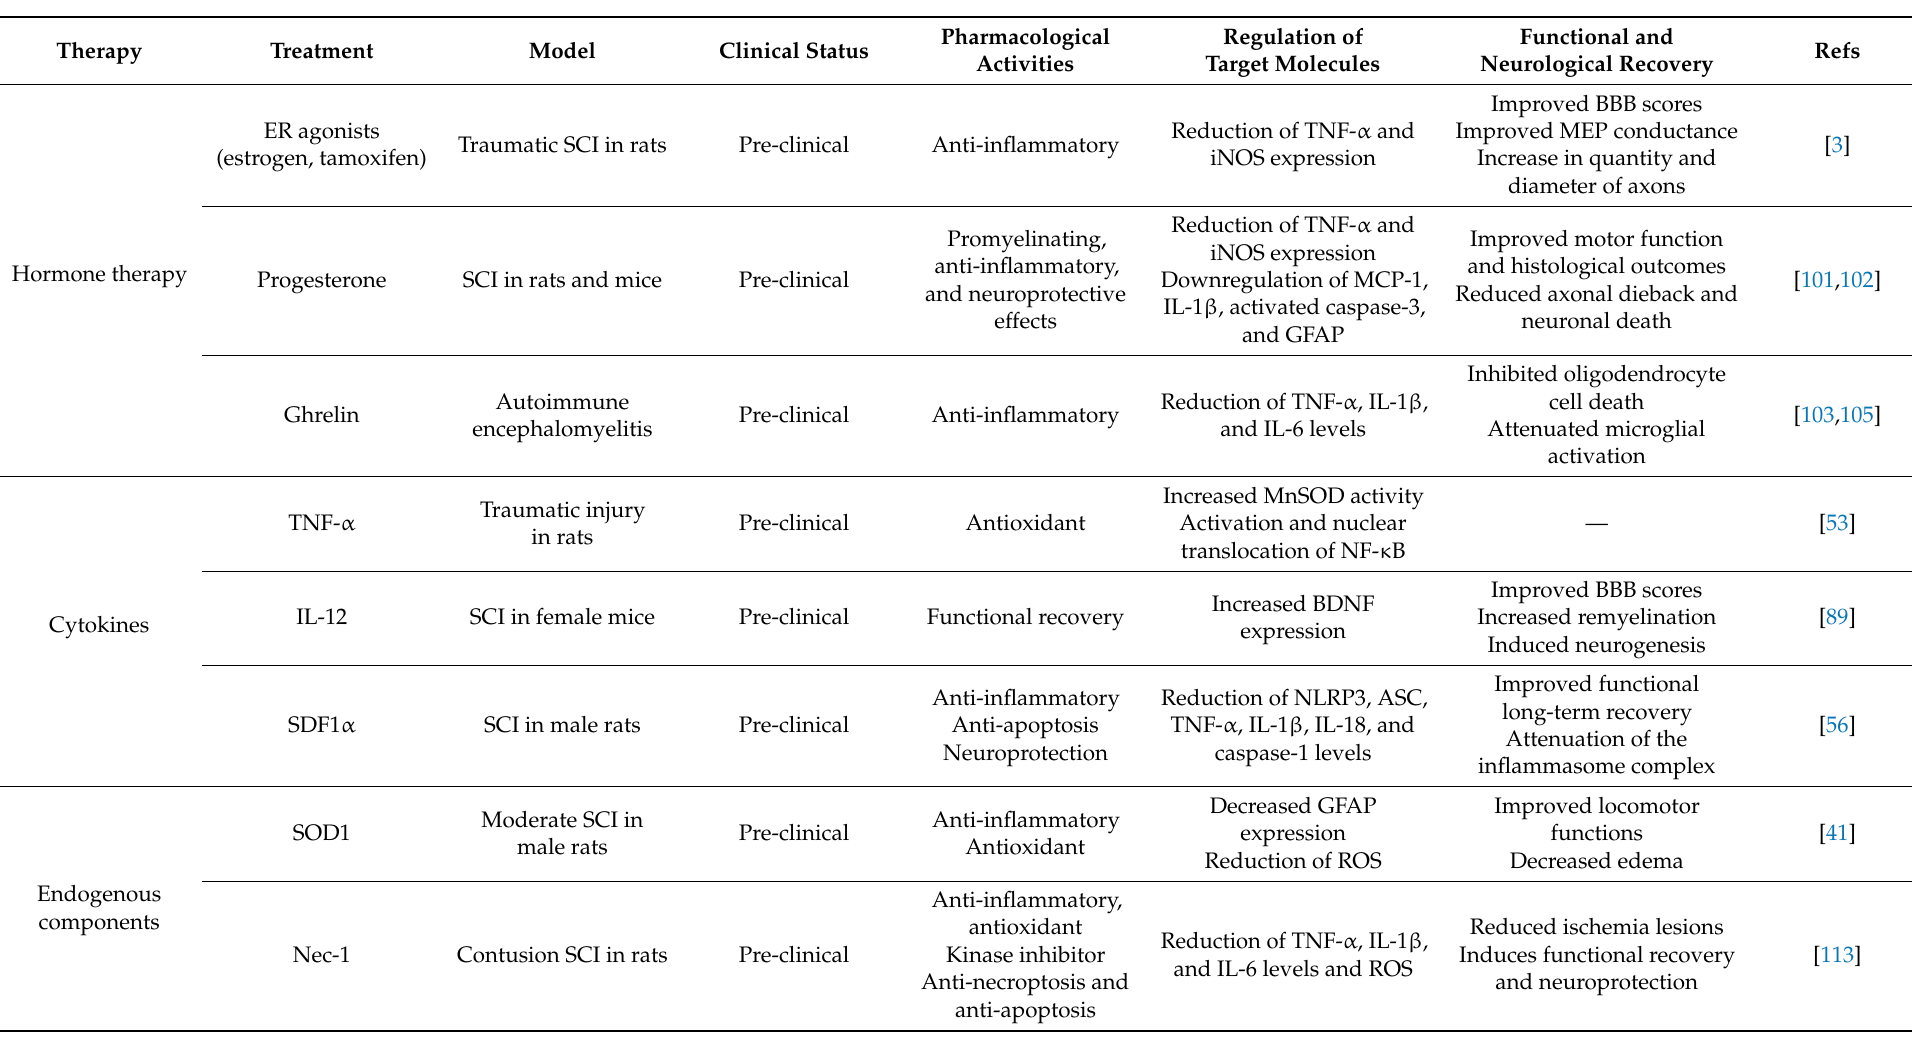
Table 2. Different therapies and their effects after SCI in animal